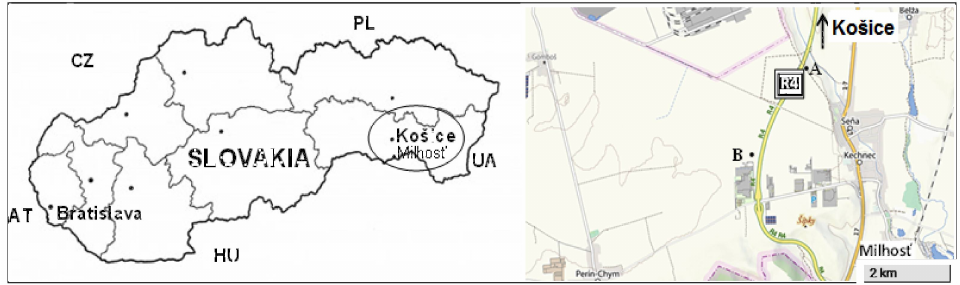
Figure 1. Location of study areas A and B near the R4 motorway Košice-Milhost’. The classification of geobiocoenoses was made according to Zlatn í k [41], while soils were classified according to the WRB IUSS [42], (Table